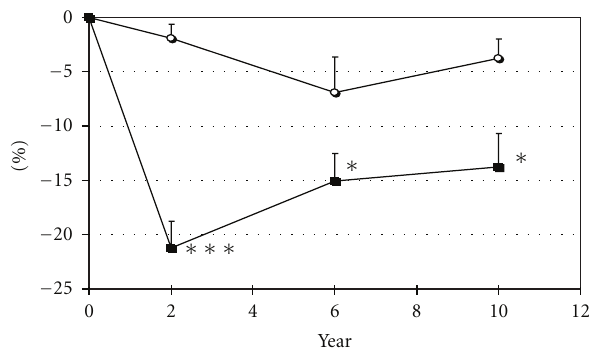
Figure 1: Mean weight change (%) at 2, 6, and 10 years of follow- up in the surgery and control groups. Filled squares: surgery; Open circles: controls. ∗∗∗ P < . 001 , ∗ P < . 05